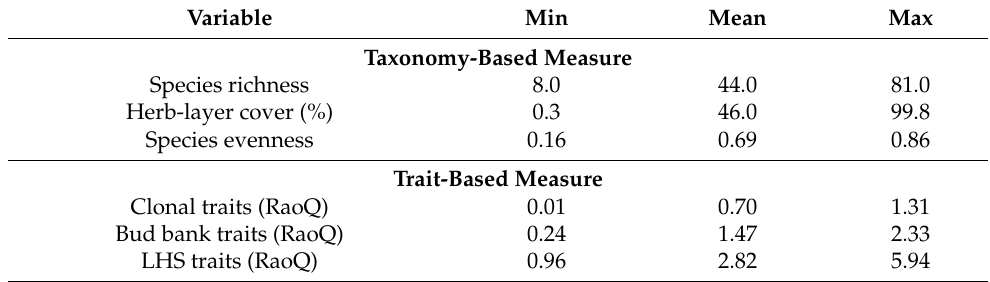
Table 3. Descriptive statistics for three taxonomy-based measures of diversity (species richness, cover, evenness) and three variables related to functional diversity (clonal, bud bank and leaf-height-seed (LHS) traits), based on 50 herb-layer forest plant communities. For traits, Rao’s quadratic entropy (RaoQ) was used as a measure of functional diversity. Variable Min Mean Max Taxonomy-Based Measure Species richness 8.0 44.0 81.0 Herb-layer cover (%) 0.3 46.0 99.8 Species evenness 0.16 0.69 0.86 Trait-Based Measure Clonal traits (RaoQ) 0.01 0.70 Bud bank traits